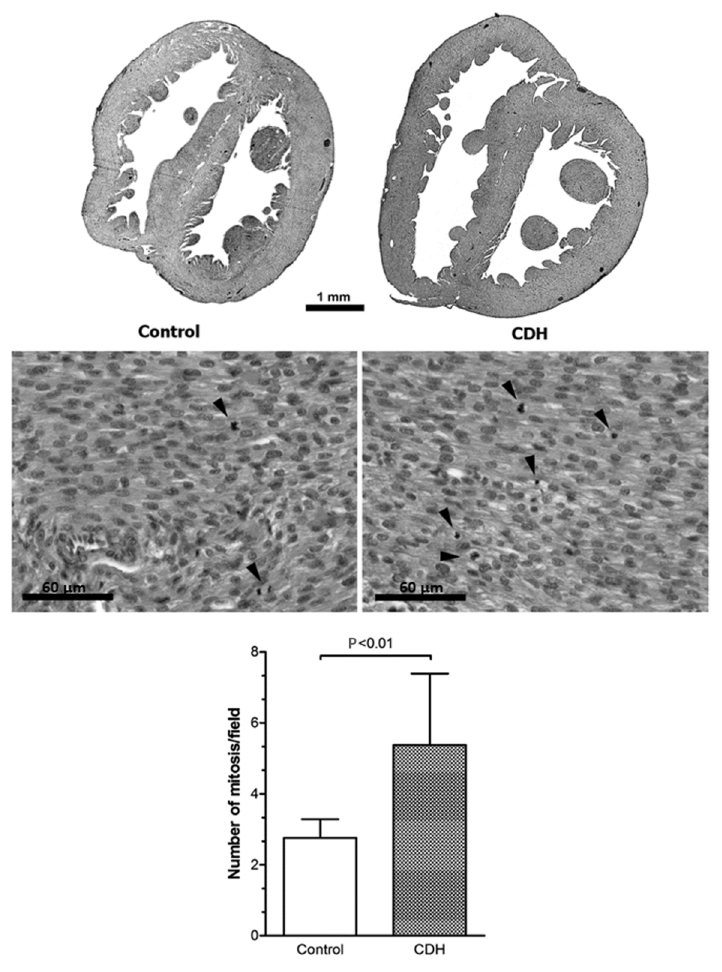
Figure 3. Histological view showing right ven- tricle dilation in the congenital diaphragmatic hernia (CDH) group. Arrows point to mitosis in right ventricle. There was an increased number of mitotic myocytes in the CDH